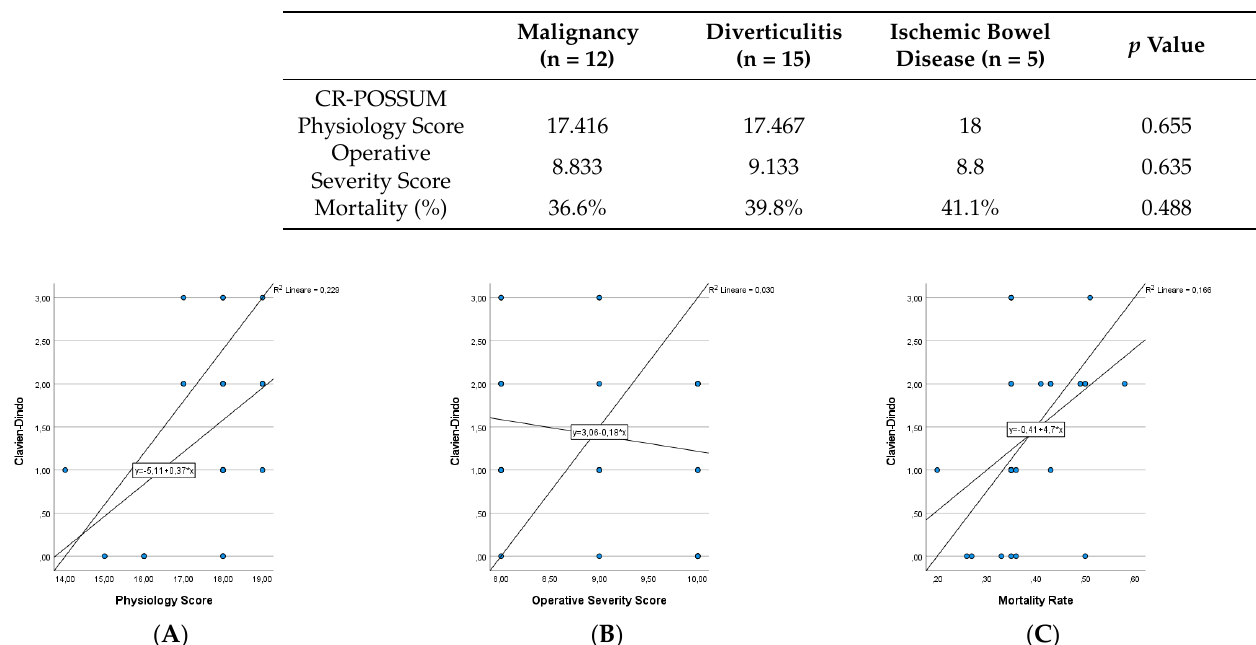
Table 5. CR-POSSUM in different colon diseases. Significance test used is ANOVA test.